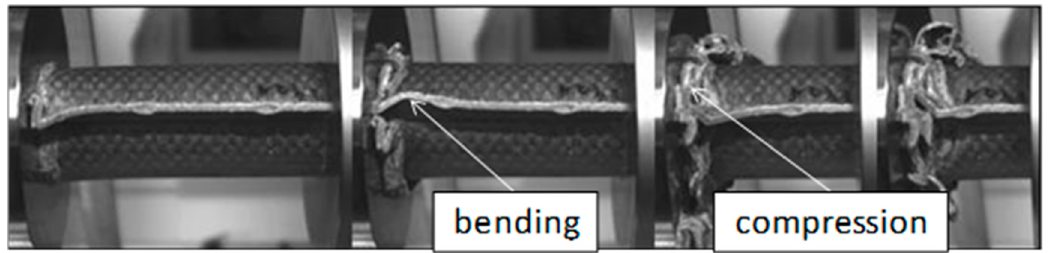
Figure 6. Deformation of V9 at quasi-static test.